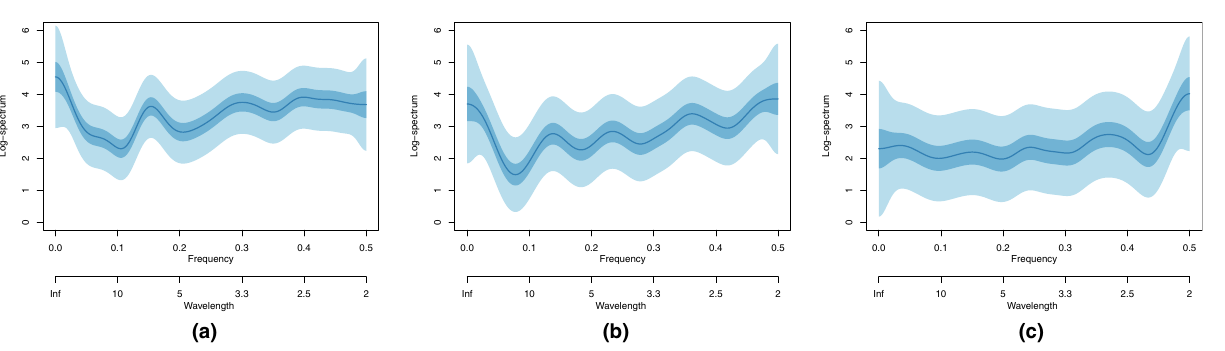
Figure 5. Bayesian log-spectral estimates and 50% and 90% credible intervals for ( a ) Group 1 countries: Spain, France, Italy, the US, the UK and Iran. Effective number of days=357; ( b ) Group 2 countries: Switzerland, Canada, Belgium and China. Effective number of days=229; ( c ) Group 3 countries: Norway, Australia and South Korea. Effective number of days = 157.